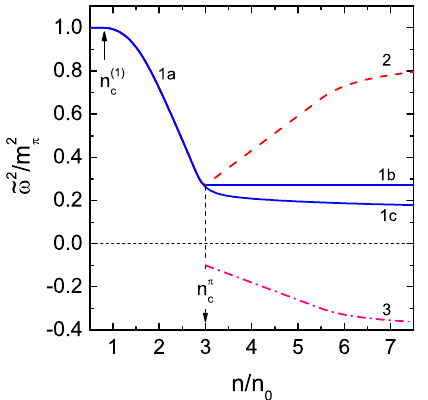
Figure 9. Typical density dependence of the effective pion gap squared. The line 1a shows ( 1 ) for n